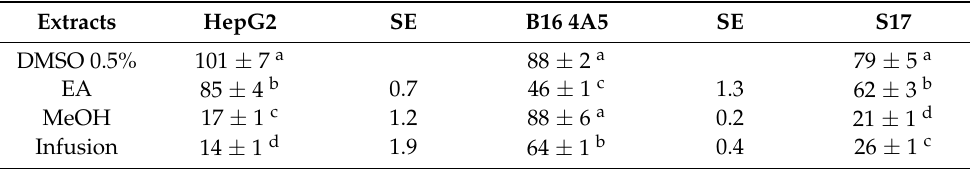
Table 5. Cellular viability (%) of the extracts on HepG2, B16 4A5, and S17 cell lines applied at the concentration of 100 µ